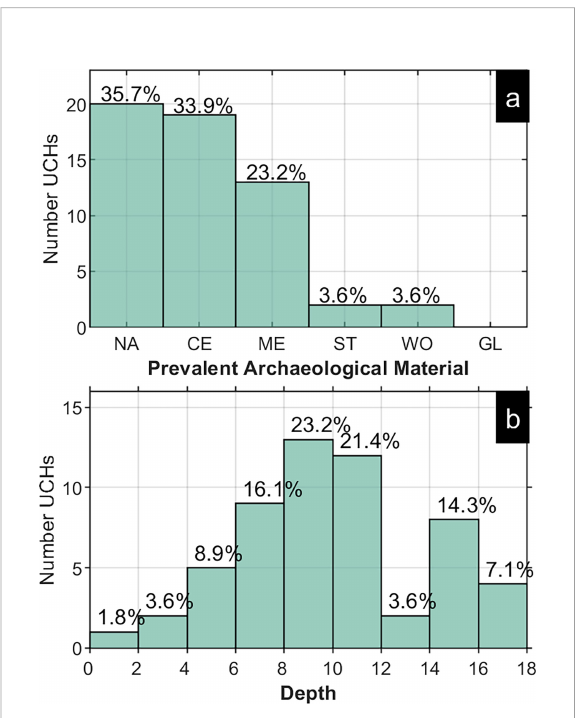
FIGURE 3 Archaeological database. (A) Prevalent archaeological material: NA, not assigned; CE, ceramics; ME, metallic; ST, stone; WO, wood/organic; GL, glass. (B) Depth of the underwater cultural heritage sites (referring to the mean sea